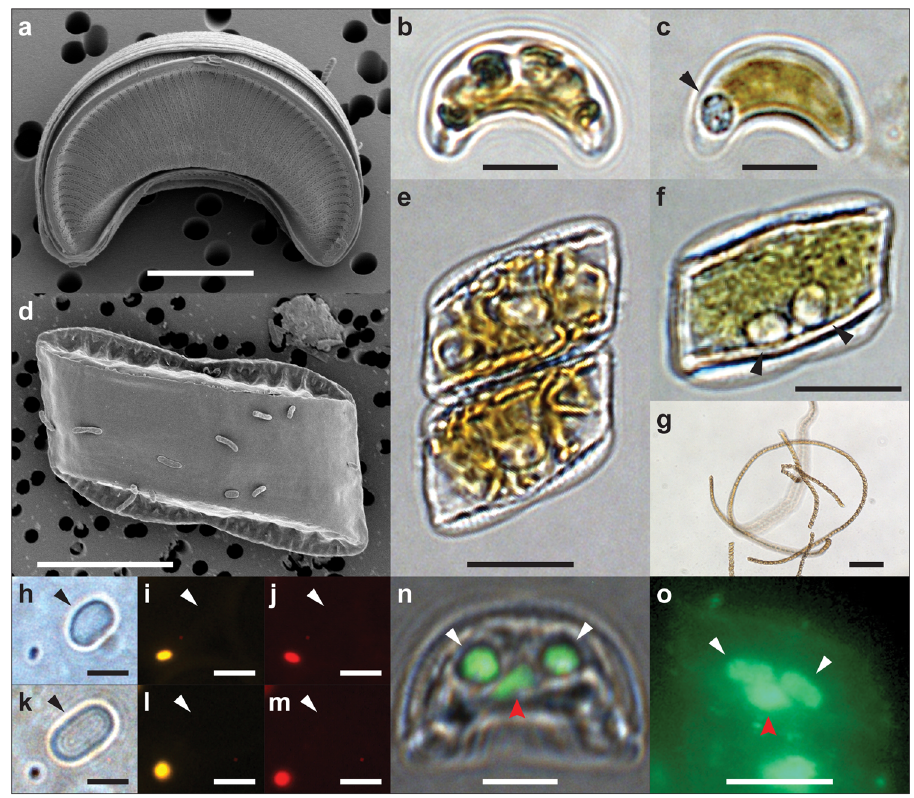
Fig. 1 Characterization of marine Epithemia and their endosymbionts. a , b , c Micrographs of E. pelagica UHM3200 in valve view, including visualization by a scanning electron microscopy, and light microscopy for b live cells and c cells osmotically shocked to display the endosymbionts, as indicated by the black arrow. The osmotic shock treatment ( c , f ) disrupts host cell contents and displaces the endosymbionts. The natural intracellular location of endosymbionts is illustrated in n and o . d , e , f , g Micrographs of E. catenata UHM3210 in girdle view, including visualization by d scanning electron microscopy, light microscopy for e live cells and f osmotically shocked cells with two endosymbionts highlighted by black arrowheads, and g undisturbed live cells growing in long chains. Micrographs of Ep SB ( h , i , j ) and Ec SB ( k , l , m ) released from crushed UHM3200 and UHM3210 host cells, respectively, as seen under bright fi eld ( h , k ), phycoerythrin fl uorescence ( i , l ), and chlorophyll fl uorescence ( j , m ). Arrowheads point to the endosymbiont cells, and a single Synechococcus WH7803 cell is present in each fi eld to serve as a positive control for fl uorescence. n , o Fluorescence micrographs of fi xed E. pelagica and E. catenata cells, respectively, where endosymbionts (white arrows) and nuclei (red arrows) have been stained with nucleic acid-binding SYBR Gold dye (green). In n , the fl uorescence channel has been overlaid on a bright fi eld micrograph. Micrograph scale bars are 5 μ m ( a – c , n ), 10 μ m ( d – f , o ), 100 μ m ( g ), and 3 μ m ( h – m ). The experiment assessing the auto fl uorescence of released endosymbionts ( h – m ) was performed once, while all other micrographs represent results that were consistently reproduced in multiple